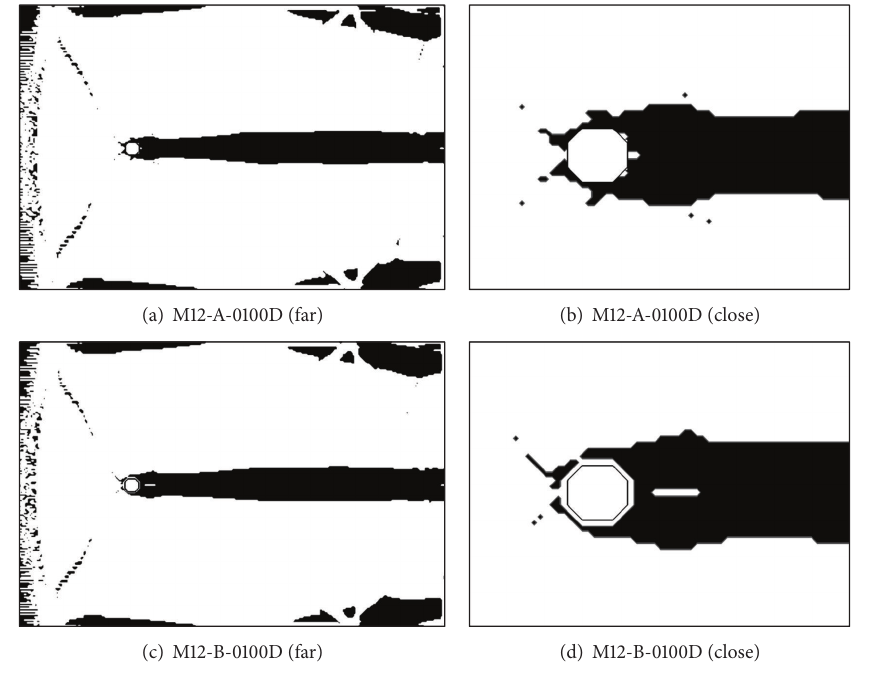
Figure 13: Visualization of switching parameter 𝛽 (white: 𝛽 = 1, black: 𝛽 = 0).